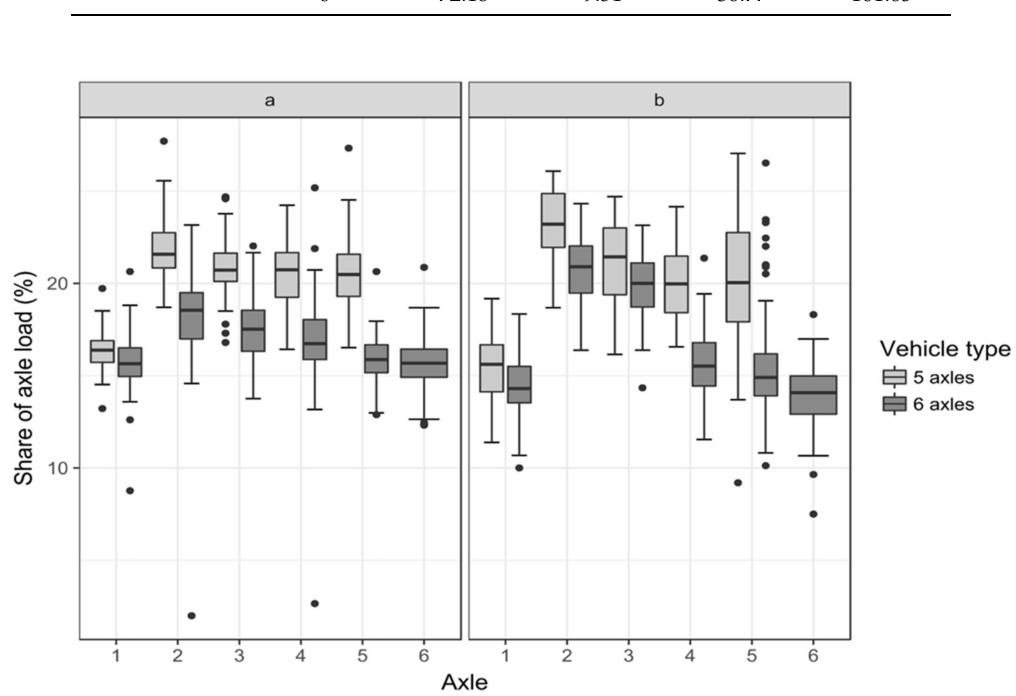
Figure 7. Distribution of the axle loads of the truck units with a semi-trailer ( a ) and a trailer ( b